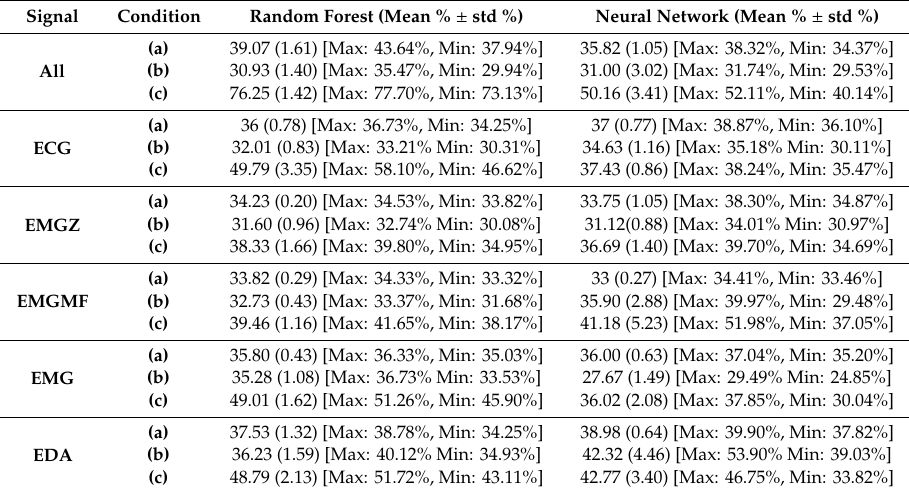
Table 4. Global result for 30s frame. The mean (standard deviation) [Maximum Minimum] F1 score obtained for the 30s classifiers in each iteration; (a) corresponds to the subject independent evaluation, (b) corresponds to the subject dependent evaluation, and (c) corresponds to emotion dependent evaluation.